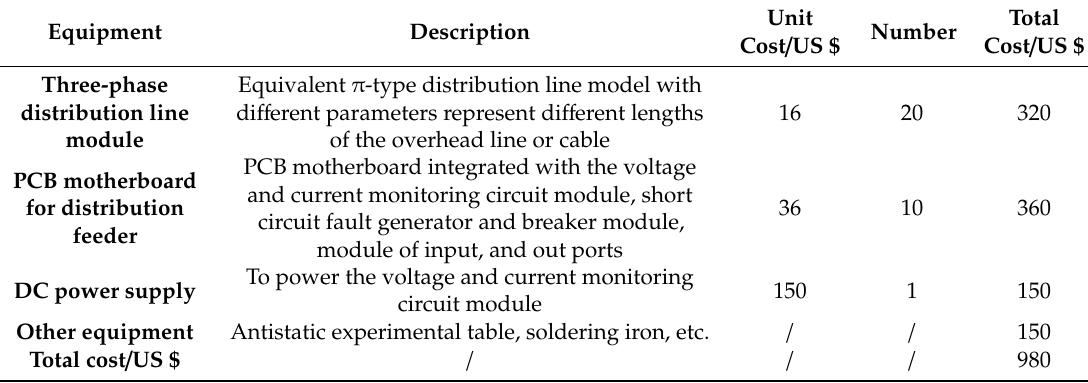
Table 1. Equipment list and its cost in our proposed platform.